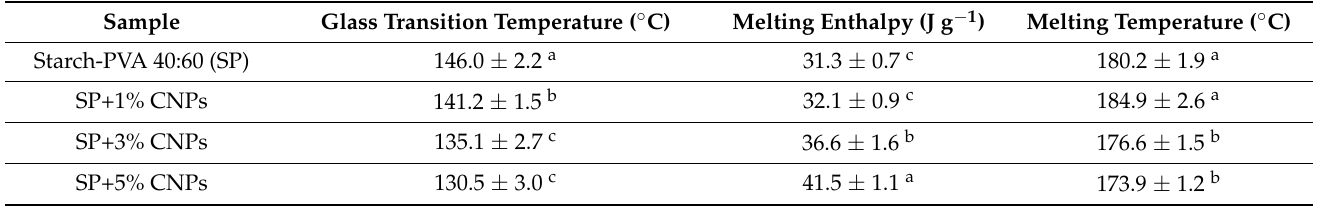
Table 1. Thermal properties of starch-PVA-based